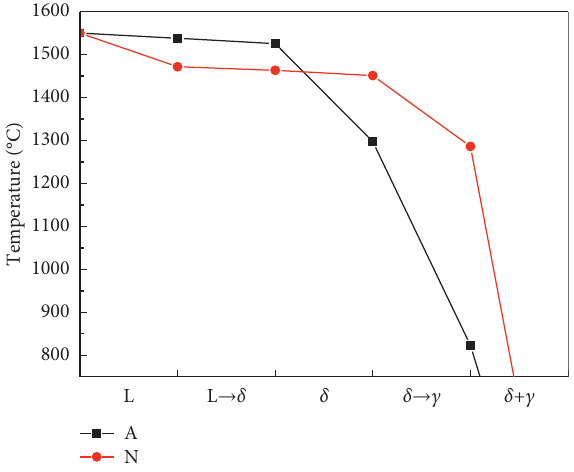
Figure 3: Phase transition